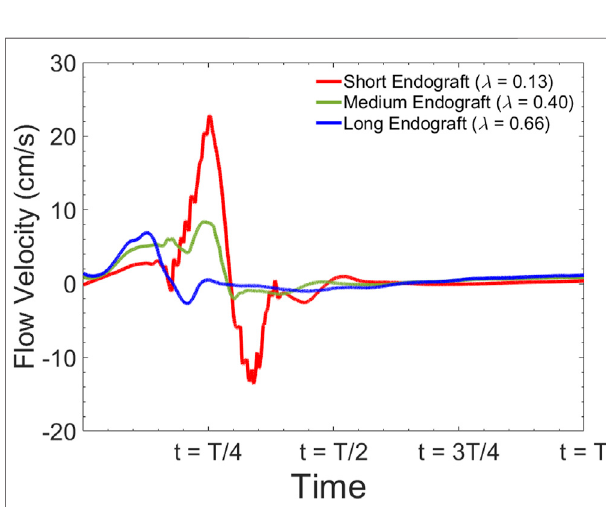
FIGURE 9 | Simulated septum wall displacement waveform for different graftlengthsduringonecardiaccycle.Thedataarecollected5 cmproximalto the distal tear.